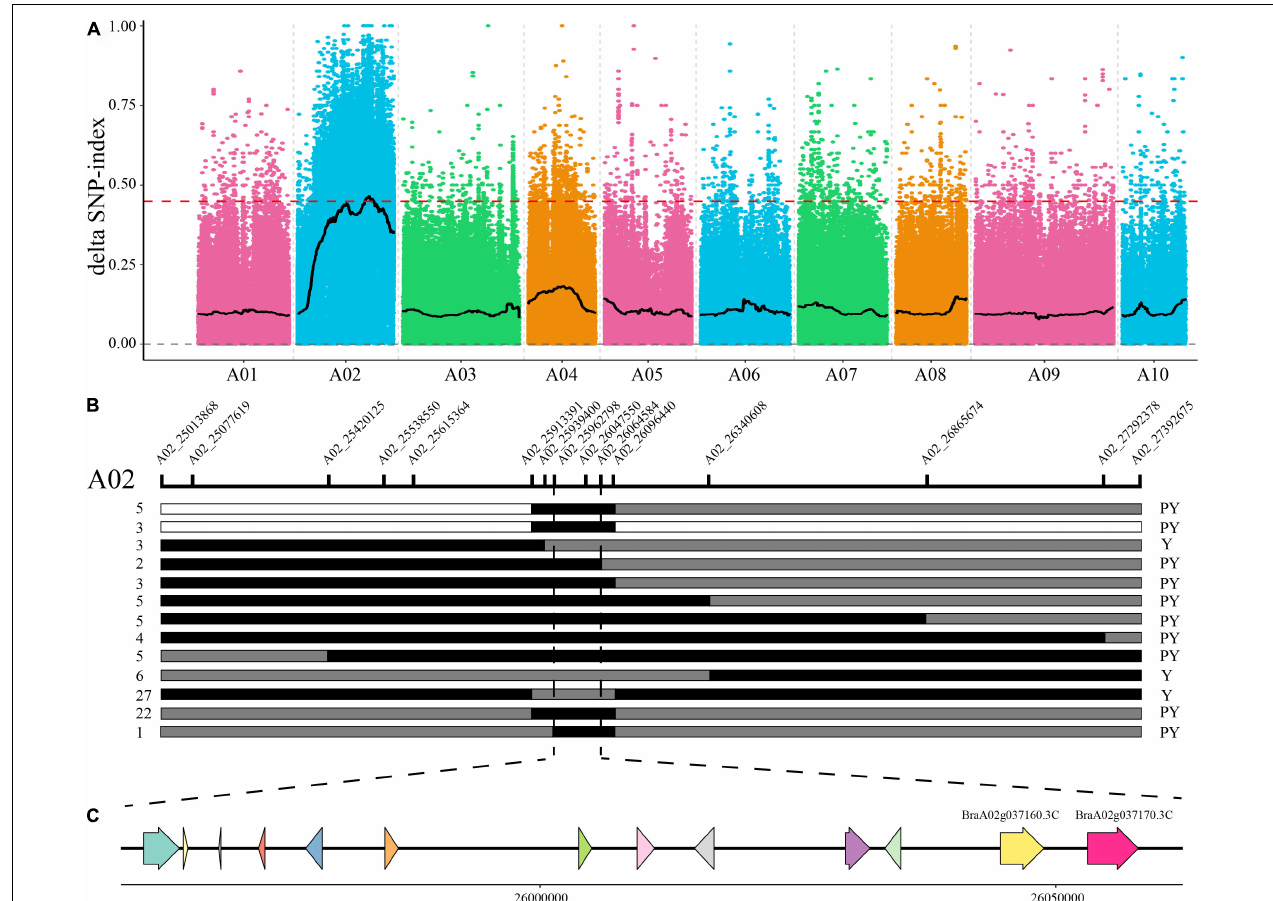
FIGURE 2 | Fine mapping of the pale-yellow petal gene BrPYP. (A) SNP index plot of 10 chromosomes produced using BSA analysis. The x-axis represents the position of the 10 chromosomes, while the y-axis represents the SNP index. The dashed line represents the index threshold (0.99). (B) F 2 and BC 1 populations were applied to the BrPYP fine map, narrowing down the area to 101.79 kb. The SNP markers used for mapping are labeled in the schematic diagram of the chromosome. The number of recombinants within the same genotype are written on the left, with phenotypes on the right. “Y” and “PY” refer to yellow and pale-yellow phenotypes, respectively. White and gray segments indicate the same genotype as the yellow parent and F 1 , respectively, while the black segment represents the same genotype as the pale-yellow parent. (C) The 13 genes in the candidate region.